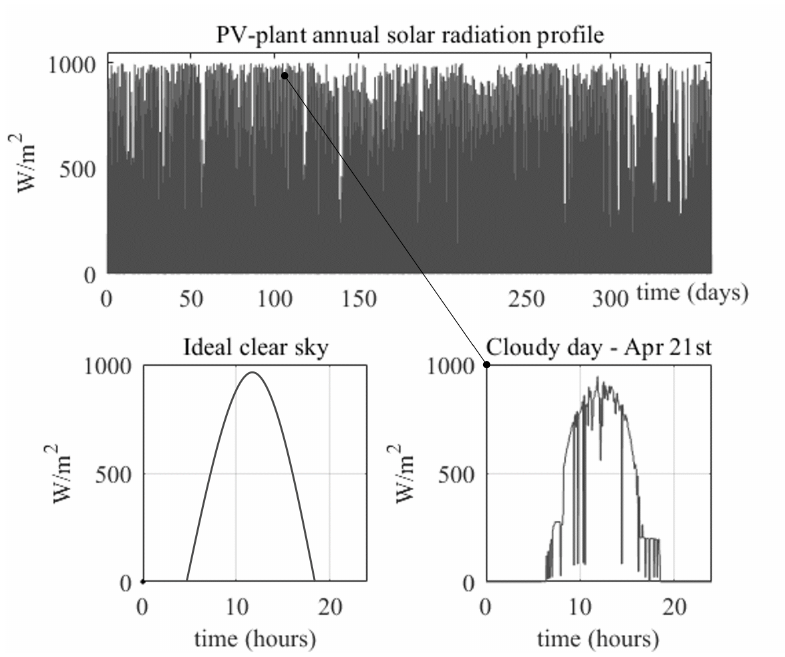
Figure 6. Collected radiation profile from PV-plant at